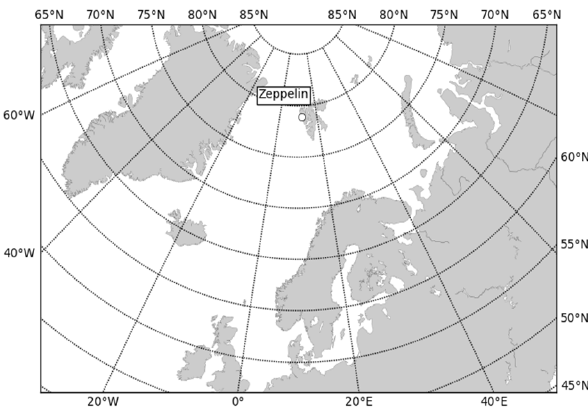
Figure 1. Mt Zeppelin station, Ny Ålesund, Svalbard at 78 ◦ 54 0 N, 11 ◦ 53 0 E